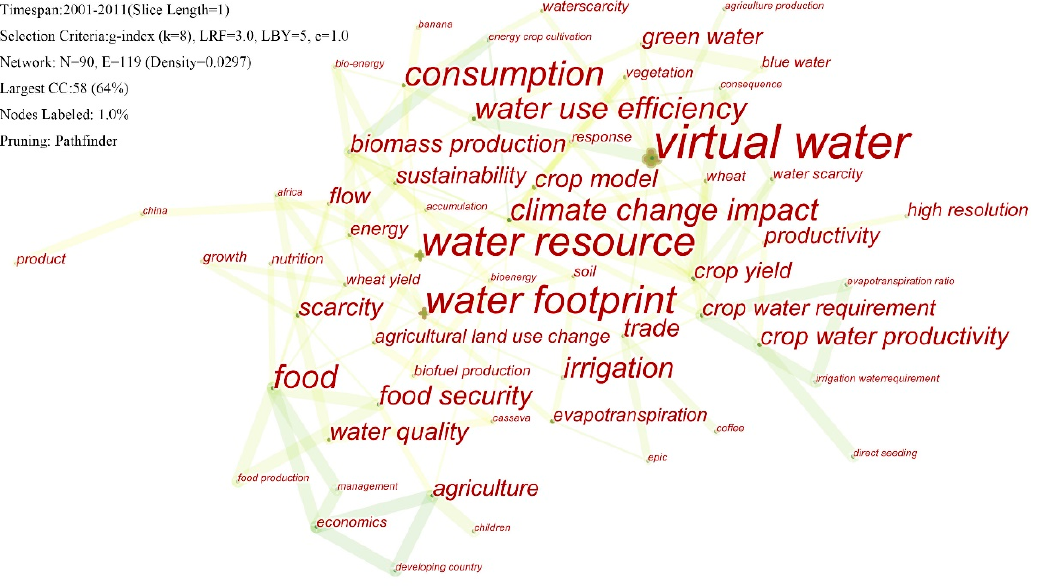
Figure 6. Co-occurrence network of keywords from 2001–2011.